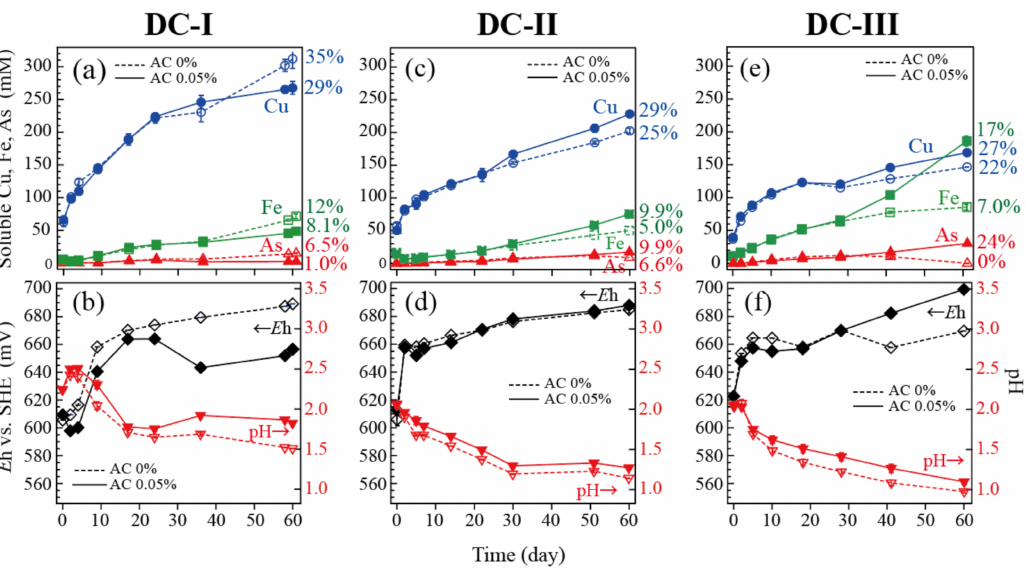
Figure 3. Activated carbon (AC) bioleaching of three concentrates: DC-I ( a , b ), DC-II ( c , d ) and DC-III ( e , f ). Changes in the total soluble Cu ( • , ), Fe ( (cid:4) , (cid:3) ) or As ( (cid:78) , (cid:52) ) concentration are shown in ( a , c , e ). (cid:35) Changes in E h ( (cid:117) , ) and pH ( (cid:72) , (cid:53) ) are shown in ( b , d , f ). AC was either absent (dotted lines) or (cid:51) added at 0.05% (solid lines). Error bars depicting averages are not visible in some cases as they are smaller than the data point symbols. Percentages marked on the right axis ( a , c , e ) were calculated as the amount of each soluble metal (on day 60) relative to its content in the